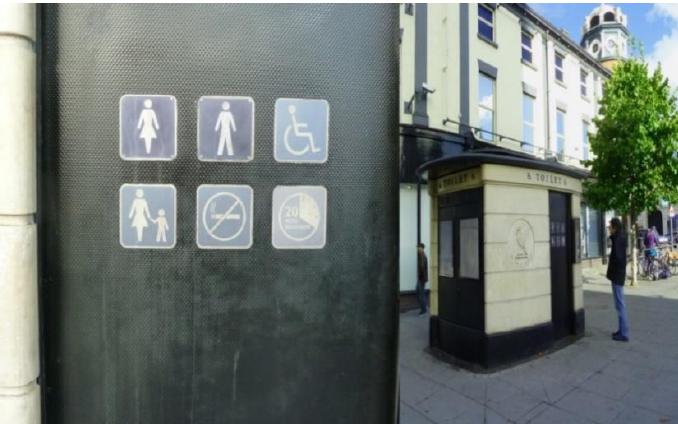
Figure 9. Example of public toilets hindering respect and social inclusion (P1) (Bold Street, Liverpool).